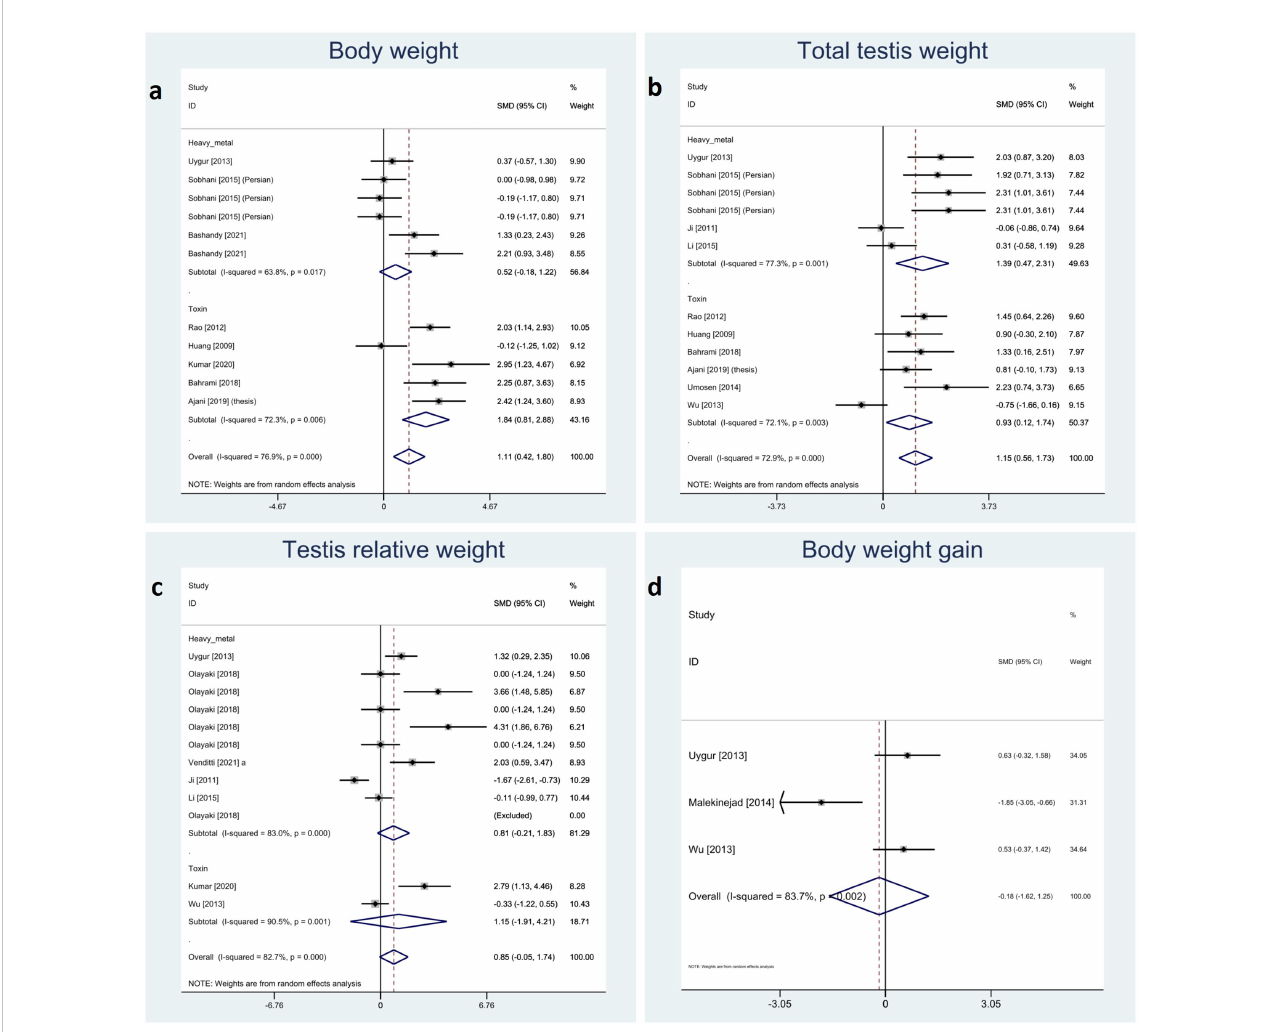
FIGURE 3 Forest plots for overall and subgroup effect measures on the impact of melatonin therapy on the (A) body, (B) total and (C) relative testicular weights and (D) body weight